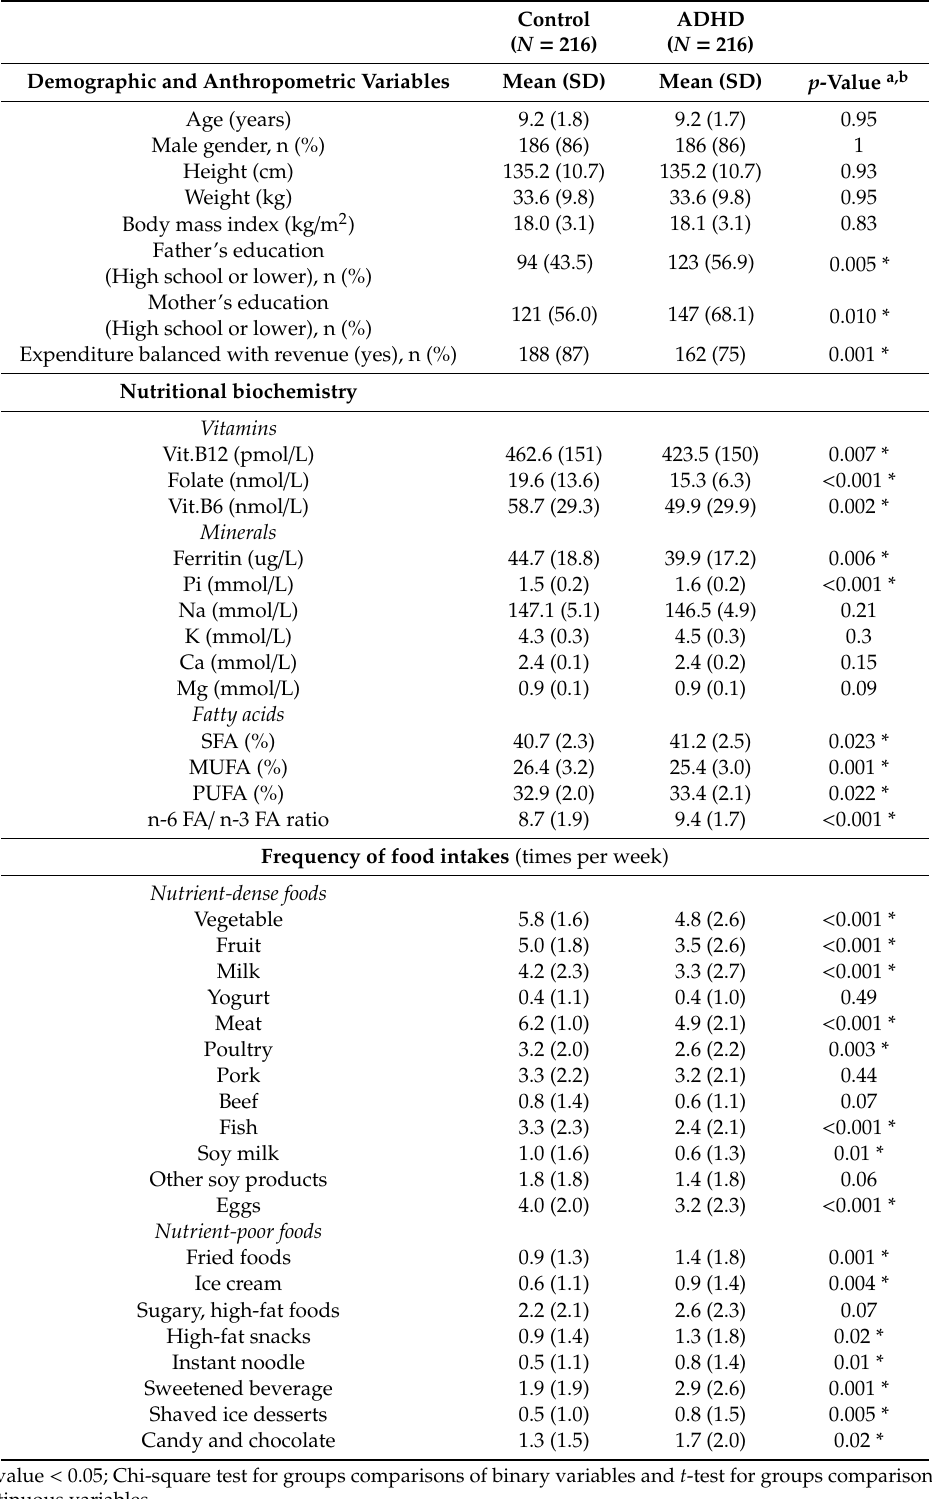
Table 1. Demographic and anthropometric data, nutritional biochemistry, and frequency of food intakes between children with ADHD and healthy